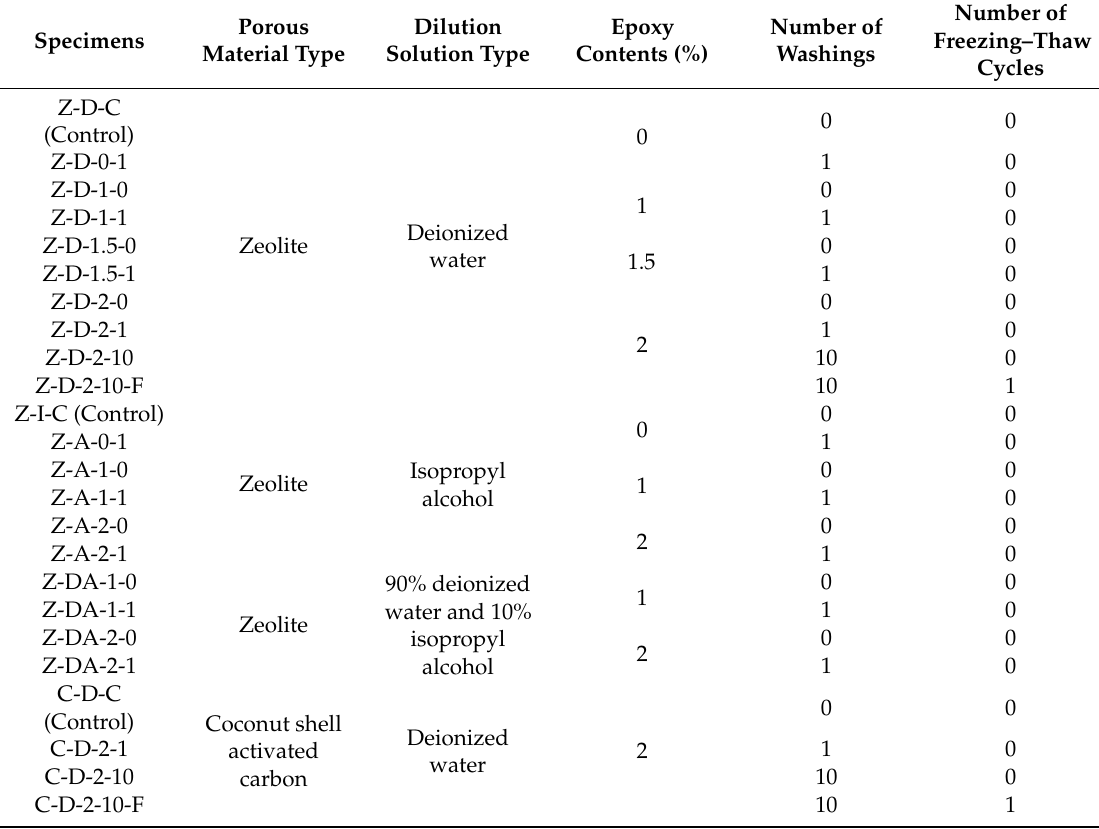
Table 3. Main parameters for evaluating the NO x and SO x removal rates of the textile fabric specimens. Porous Dilution Specimens Material Type Solution